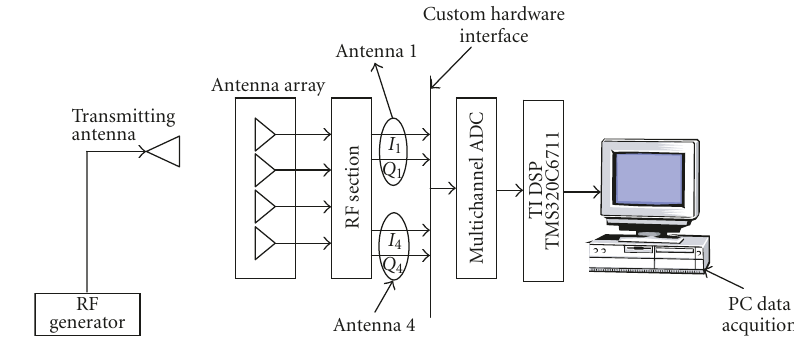
Figure 9: UKM testbed receiver experimental setup.